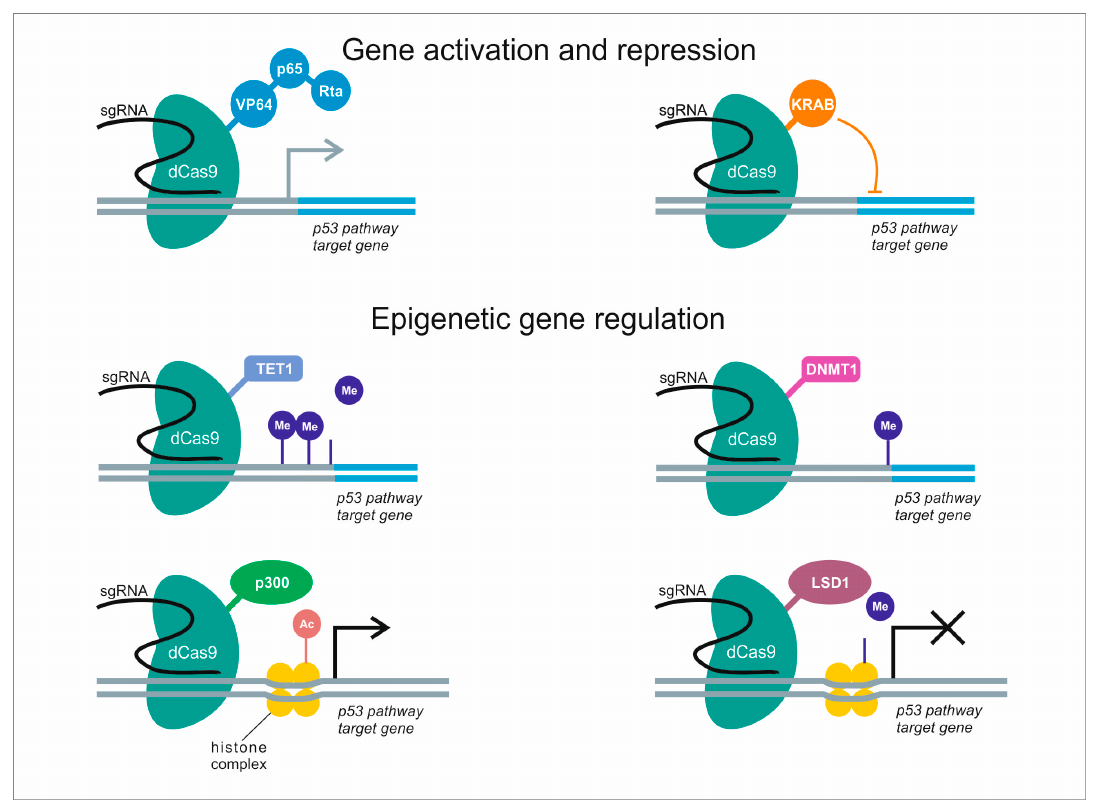
Figure 4. Potential applications of CRISPR / dCas9 system for regulation of p53 pathway genes. dCas9-mediated regulation of gene expression is guided by sgRNA, whereby dCas9 can be fused to a variety of transcriptional modulators to activate (VP64, p65, Rta) or repress (KRAB) target gene transcription. In addition, dCas9 fused to histone-modifying enzymes can modulate (TET1, DNMT1), activate (p300) or inhibit (LSD1) p53 pathway gene expression by epigenetic regulation.